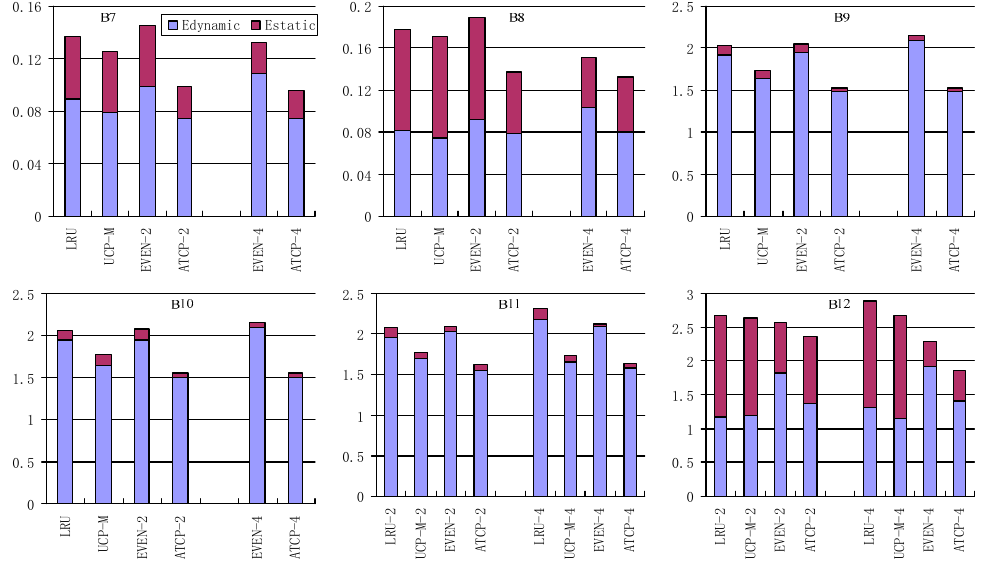
Figure 12. Energy consumed by L2 for multi-item mix-mode workloads.